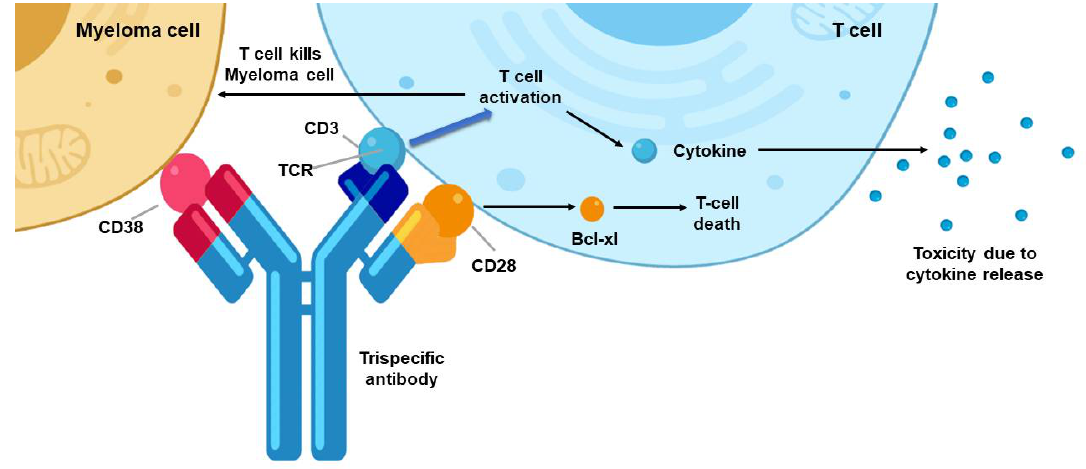
Figure 2. The design of a triple specific T cell engager (TriTE) antibody and how it links the T cells to the targeted cancer cells. This trispecific antibody binds three targets: the CD38 protein on a myeloma cell, and the protein CD28 and the CD3 protein complex on a T cell (the antibody’s target-binding domains are shown in red, blue and yellow, respectively). CD3 is a component of the T cell receptor (TCR). The binding of CD3 by the antibody drives T cell activation without requiring antigen recognition by the TCR, which leads to the killing of the myeloma cell and the production and release of toxic cytokine molecules. This image is modified from that in Garfall AL and June C, Nature, 2019 [53], and it was made using BioRender.